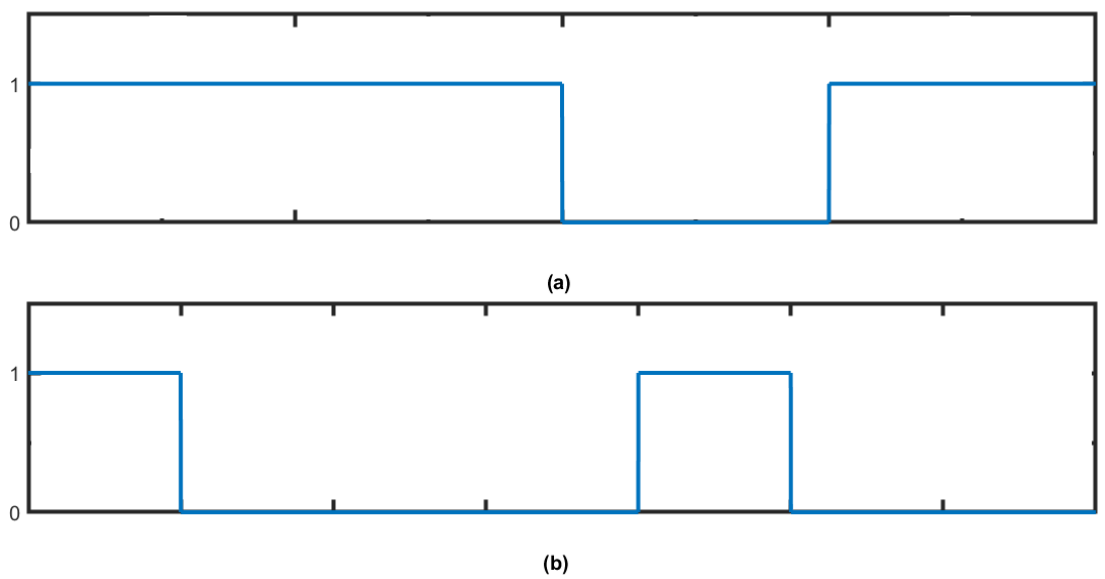
Figure 4. Waveforms of ( a ) 2-bit data ( b ) DPIM-modulated waveform. DS-PIM-Based SIM OFDM